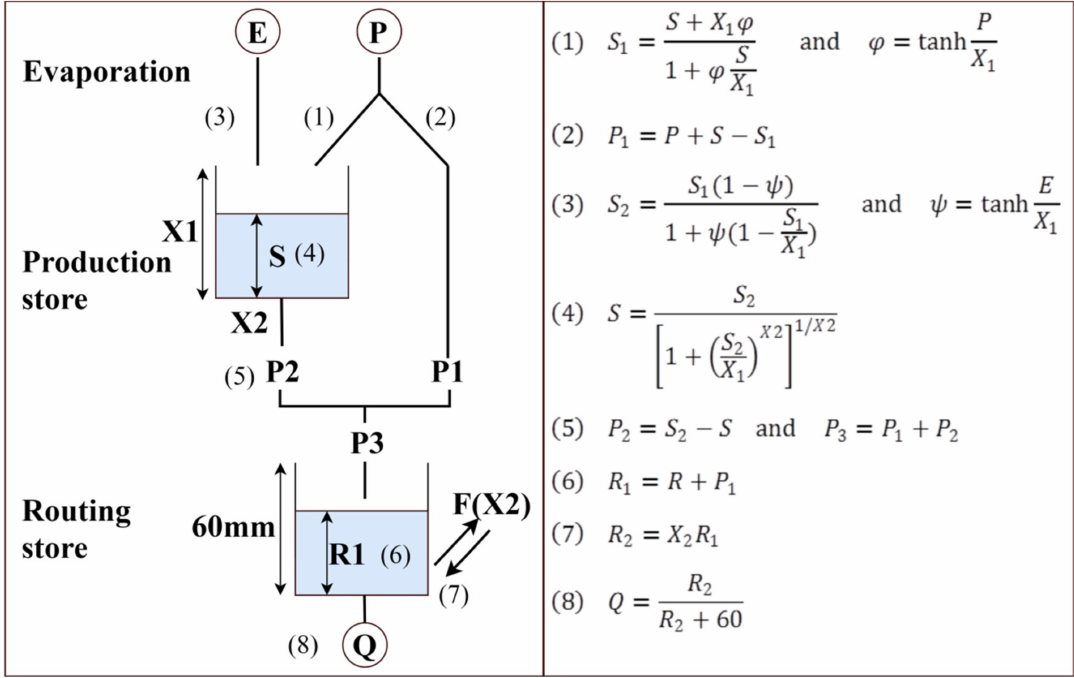
Figure 2. The conceptual framework of the GR2M model